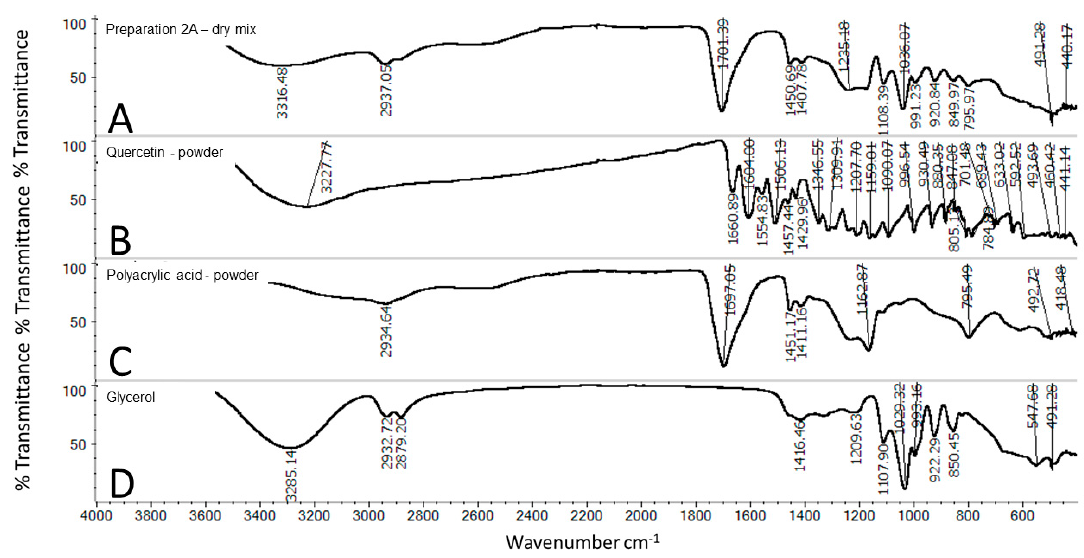
Figure 5. Fourier-transform infrared spectroscopy (FTIR) spectra of: physical mixture ( A ) of quercetin powder, PAA, glycerol in ratios reflecting the composition of 2A, quercetin ( B ), PAA ( C ) and glycerol ( D ).